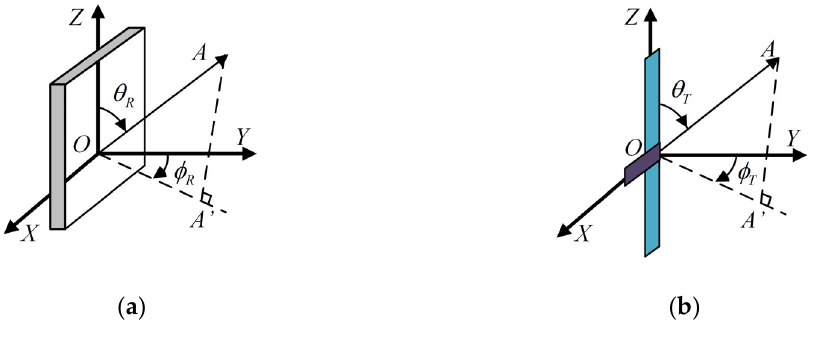
Figure 2. Spherical coordinate of discrete antenna. ( a ) Reader antenna with half-wave square patch. ( b ) Passive tag antenna with half-wave dipole.